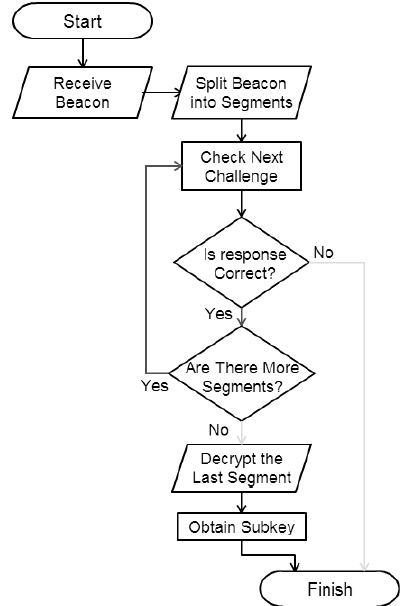
Figure 2. Flowchart of the proposed